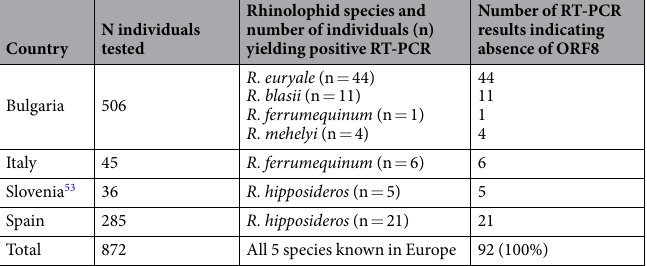
Infectious viruses were rescued from cDNA as described 25 . 24 h after co-electroporation of in-vitro transcribed RNA and nucleocapsid subgenomic RNA, parts of the cell culture supernatant were transferred to VeroFM cells and virus replication was monitored by real-time RT-PCR. 72 h post infection (hpi), rSCV 8full , rSCV epi and rSCV del8–2 gave evidence of replication by real-time RT-PCR, while rSCV del8–1 RNA increased more slowly, reach- ing a plateau level only by 96 hpi.